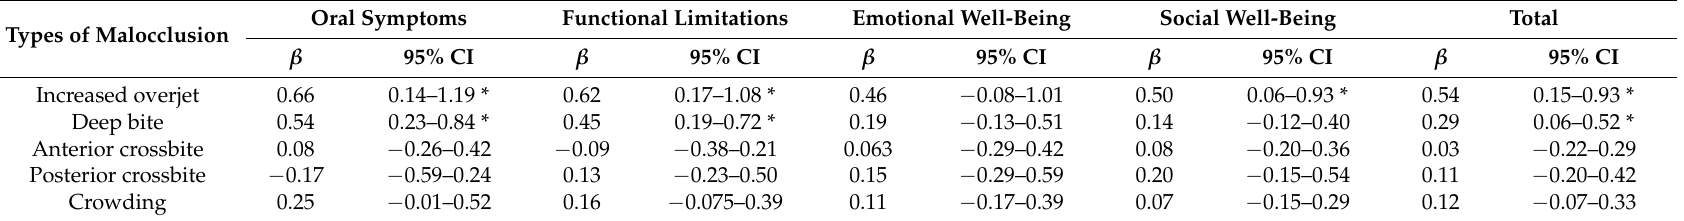
Table 4. Associations between malocclusion types and scores for the Child Perceptions Questionnaire and its four individual domains. Types of